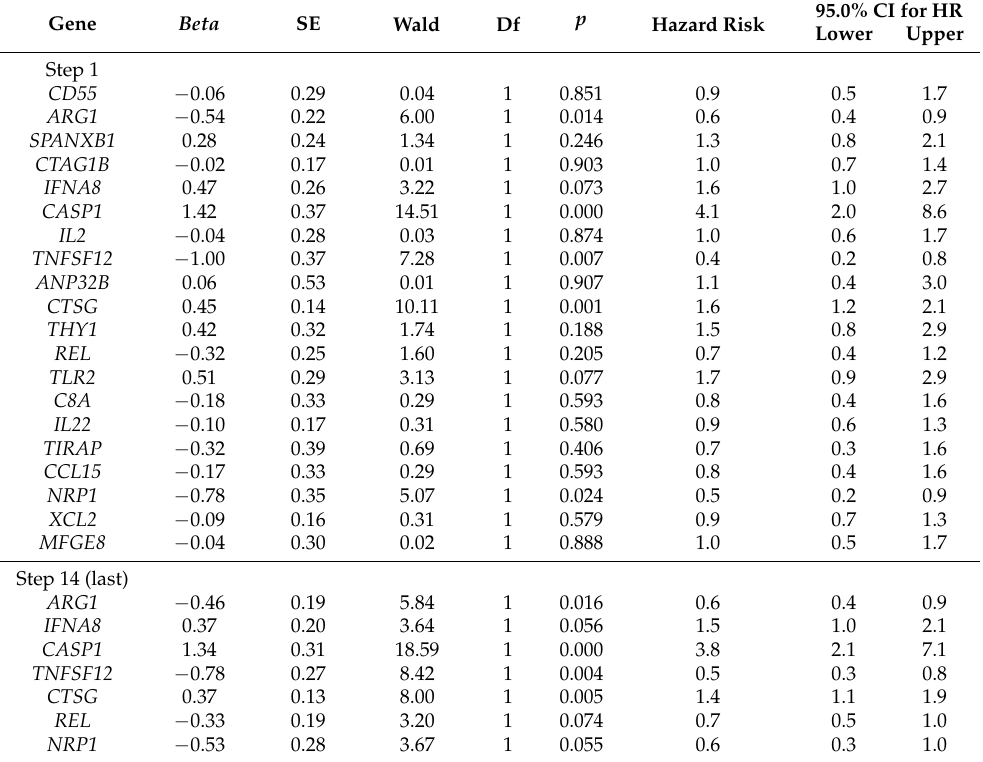
Table 3. Correlations between the top 20 genes of the multilayer perceptron and the overall survival of the